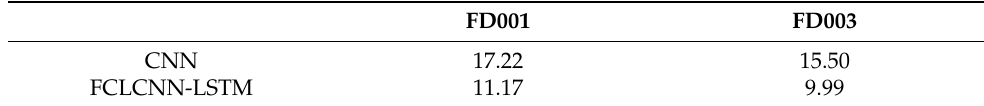
Table 6. RMSE predicted by FD001 and FD003 under the two models.